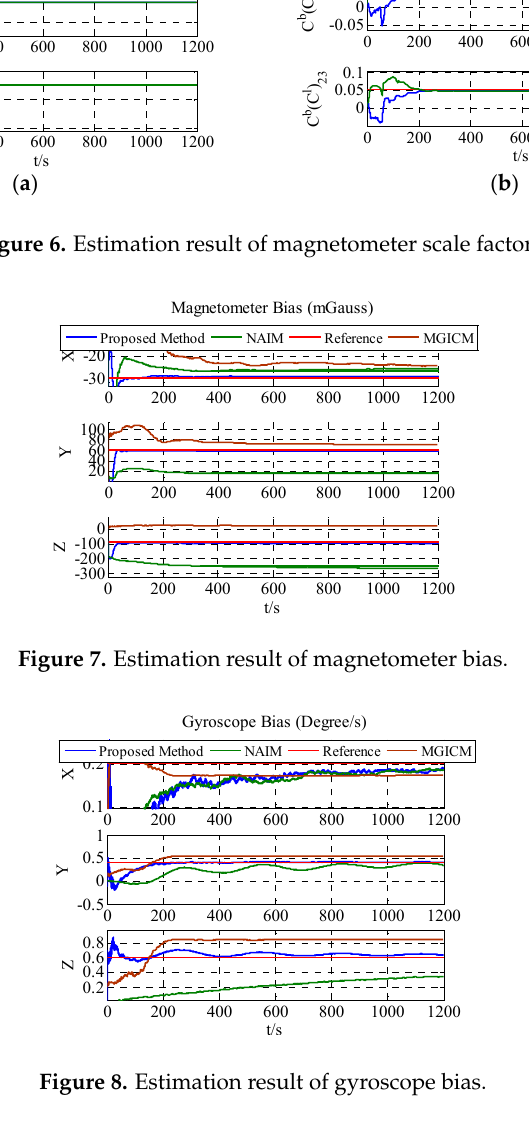
( b ) Figure 9. Estimation result of magnetometer scale factors. The calibration results are summarized in Table 3. In Figures 7–9, the red line is the reference value, and the blue, green, and brown lines represent the estimation results of the proposed method, NAIM, and MGICM. Figures 7 and 9 show the estimation result of the magnetometer, from which it is evident that the results of the NAIM and MGICM converge to incorrect values; by contrast, the results of the proposed method gradually converge to the reference. The result of magnetometer calibration is the basis of gyroscope calibration. Figure 8 indicates the simulation results of gyroscope bias. In Figure 8, the estimation results of the proposed method quickly and accurately converge to the reference values. In comparison, the estimation of NAIM and MGICM cannot get close to the reference. In conclusion, when the system only rotates around the z -axis, the NAIM and MGICM cannot calibrate the system because of a lack of sufficient data in that direction. However, the proposed method can complete calibration successfully, which indicates that it boasts better adaptability and important application value in actual systems. Table 3. Simulation results. Method